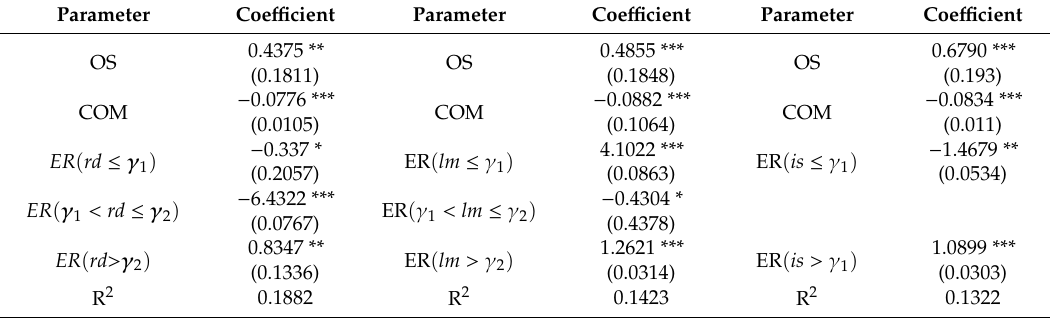
Table 5. Estimation results of panel threshold model